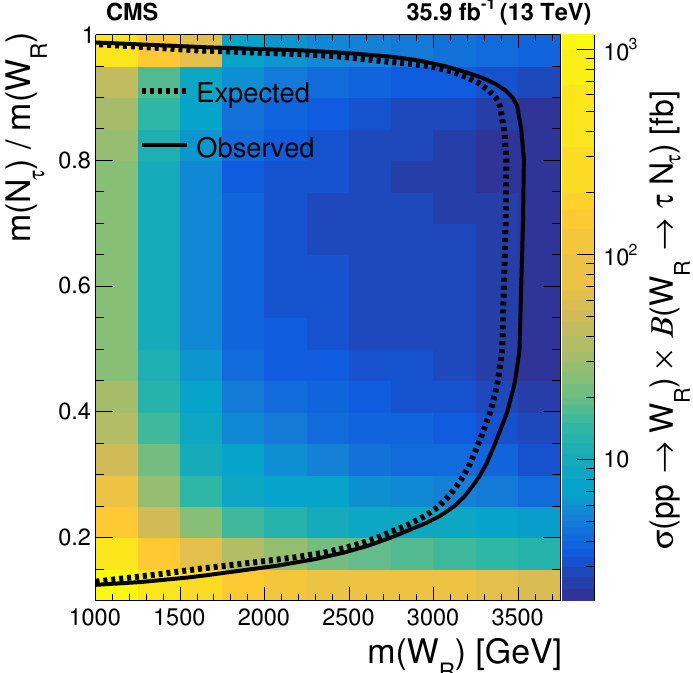
Figure 7 . Expected and observed limits at 95% CL on the product of the cross section and the branching fraction (W R ! (cid:28) N